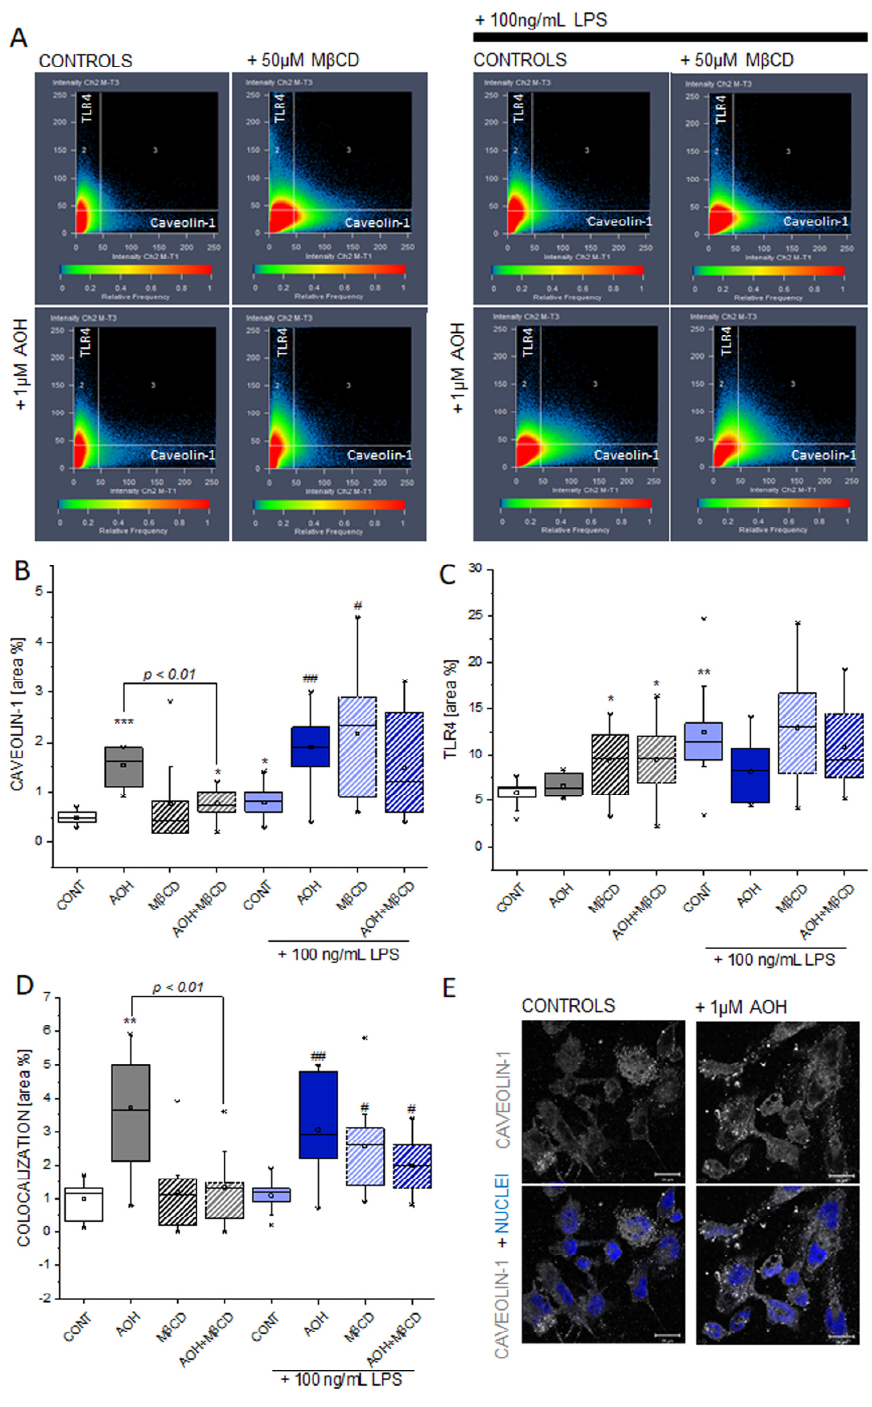
Figure 6. Influence of AOH on the immunolocalization of caveolin-1 and TLR4. Signal intensity and co-localization of the fluorescent signals ( A ). Area of caveolin-1 signal ( B ), TLR4 ( C ) and co-localization ( D ), after 1 h incubation with 1 µ M AOH, 50 µ M M β CD, or both in presence or absence of 100 ng / mL LPS. Appearance of the immunolocalization of caveolin-1 in THP-1 macrophages in control conditions and after 1 h incubation with 1 µ M AOH ( E ). Scale bar, 20 µ m. Data are mean of n ≥ 8–9 optical fields obtained from three independent experiments, * ( p < 0.05), ** ( p < 0.01), *** ( p < 0.001) and # ( p < 0.05), ## ( p < 0.01) indicate significant di ff erences in comparison to controls (CONT) and CONT + LPS, respectively (Mann–Whitney